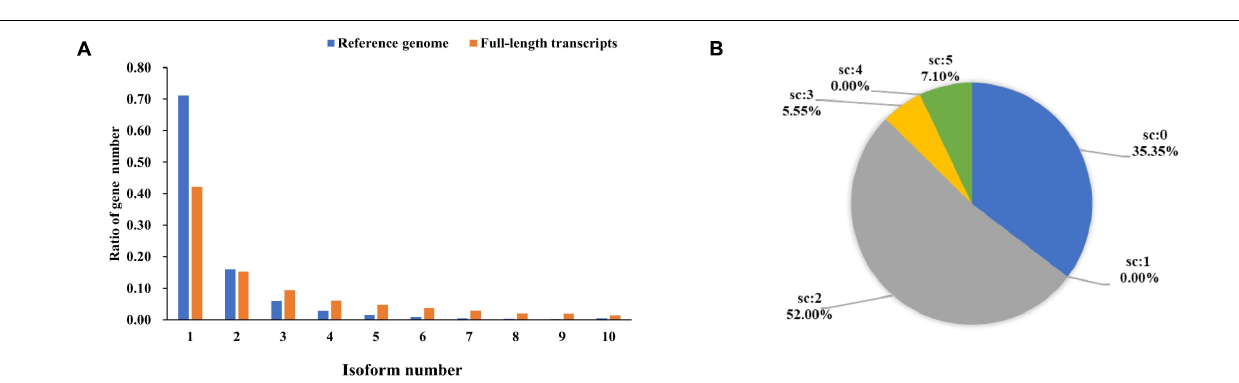
FIGURE 4 | (A) Quantity distribution of mallard duck reference genome and full-length non-redundant transcripts. (B) Proportional distribution of structural annotations of full-length transcripts. (Score = 0, isoform overlaps gene, but little or no exon congruence; Score = 1, Some exons overlap, overlaps are 1-for-1 where they exist; Score = 2, The best match among all transcripts with score of 1; Score = 3, One-for-one exon match, but sizes of internal exons disagree; Score = 4, Like 5, but leading and trailing edge sizes differ by a larger amount than the score-5 transcript found for this gene; Score = 5, Iso-Seq exons match annotation exons one-for-one. Sizes agree except for leading and trailing